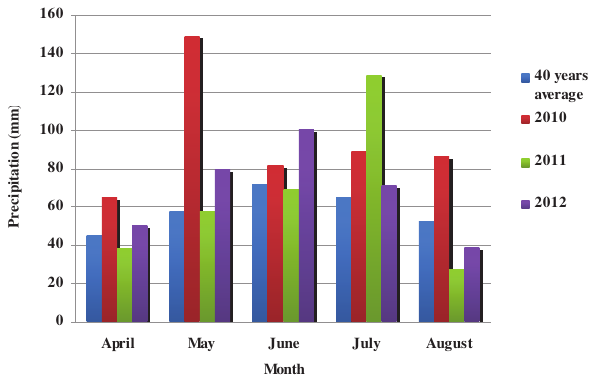
Figure 1: Precipitation (mm) from April to August (Debrecen-Pallag, 2010- 2012)